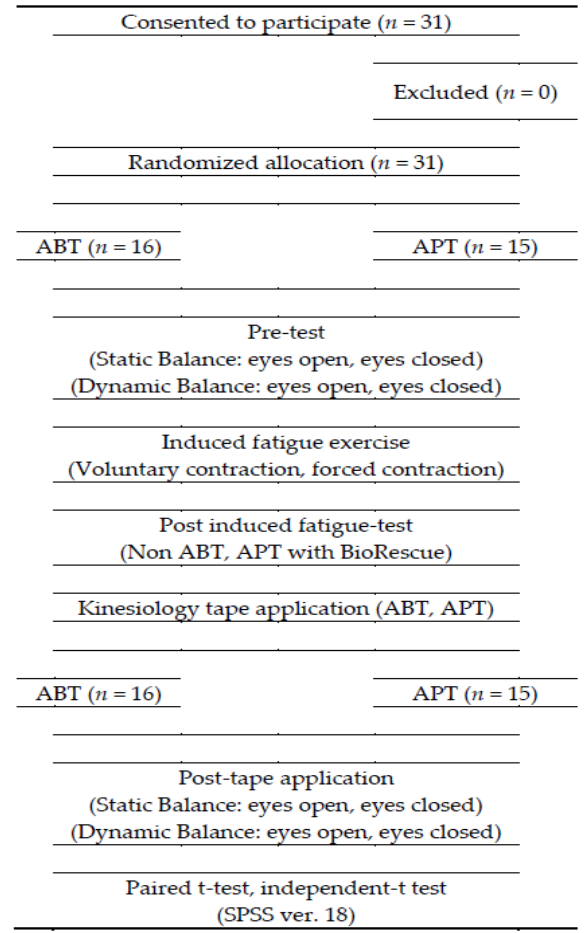
Figure 1. Flow diagram for the study. Healthcare 2020 , 8 , x